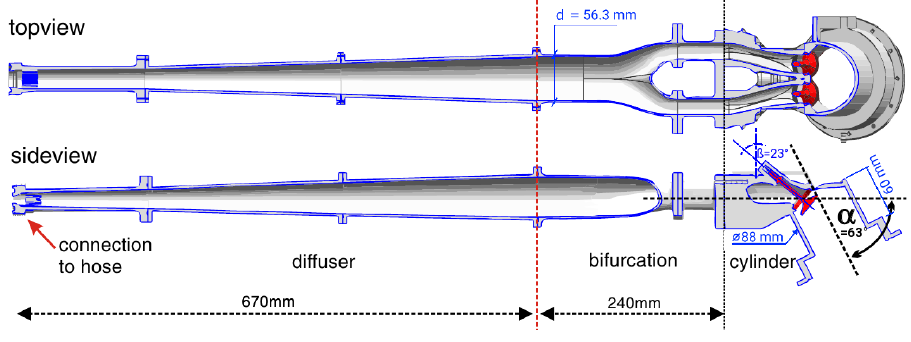
Figure 1. Magnetic resonance velocimetry (MRV) flow bench configuration [15].